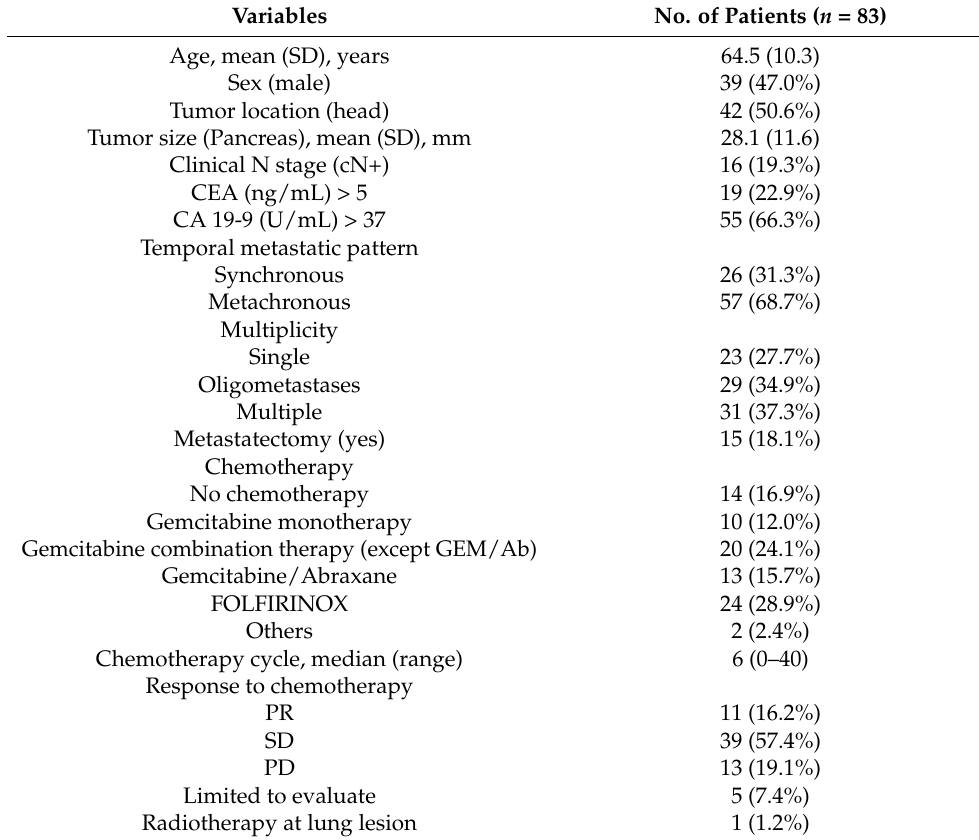
Table 1. Demographics of PDAC patients with isolated pulmonary